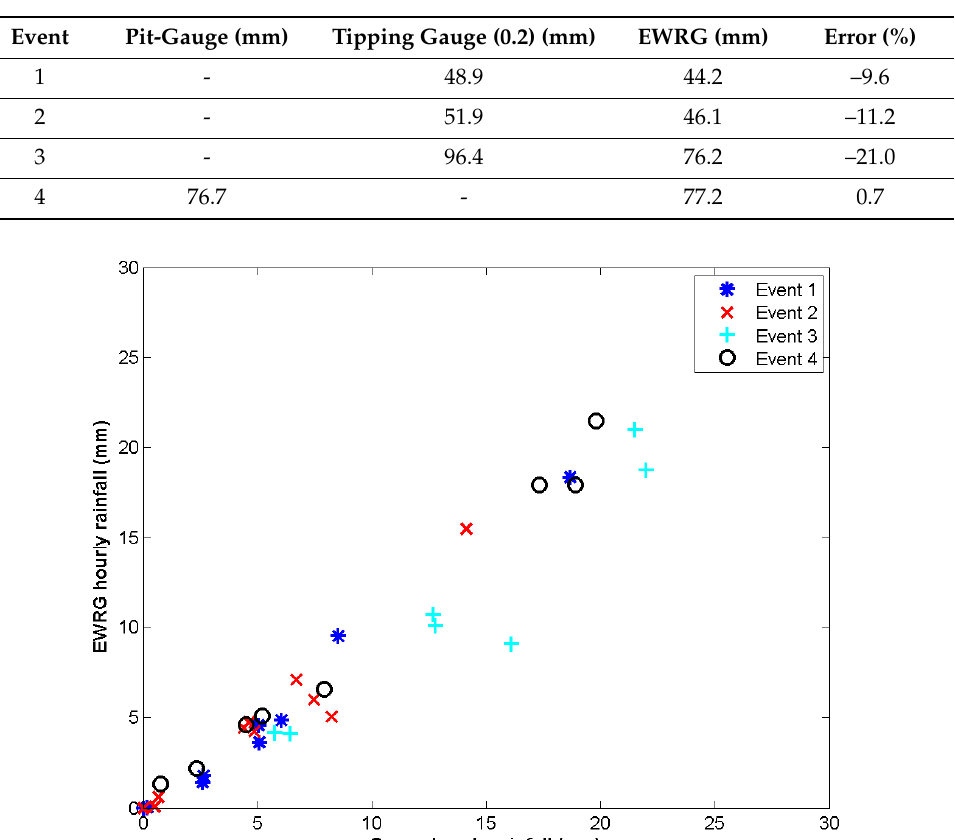
Figure 17. Scatterplot of hourly rainfall of EWRG and rain gauge for all events. Table 3. Comparison results of hourly rainfall between the EWRG and ground-based equipment (Pit-Gauge, Tipping